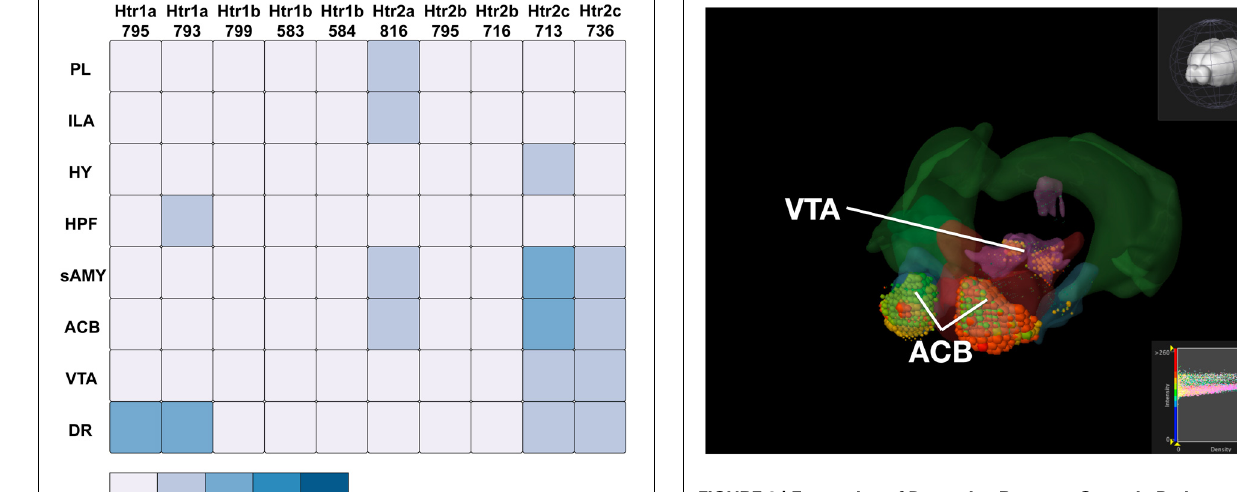
FIGURE 8 | Expression of Dopamine Receptor Genes in Brain Structures Associated with Reward Processing Using Brain Explorer 2. Colored spheres represent the amount of expression in a given brain structure, where blue–green is low, yellow is medium, and red is high. Spheres also represent each 200- µ m 3 voxel, with the size of the spheres directly proportional to the number of objects detected in each voxel.